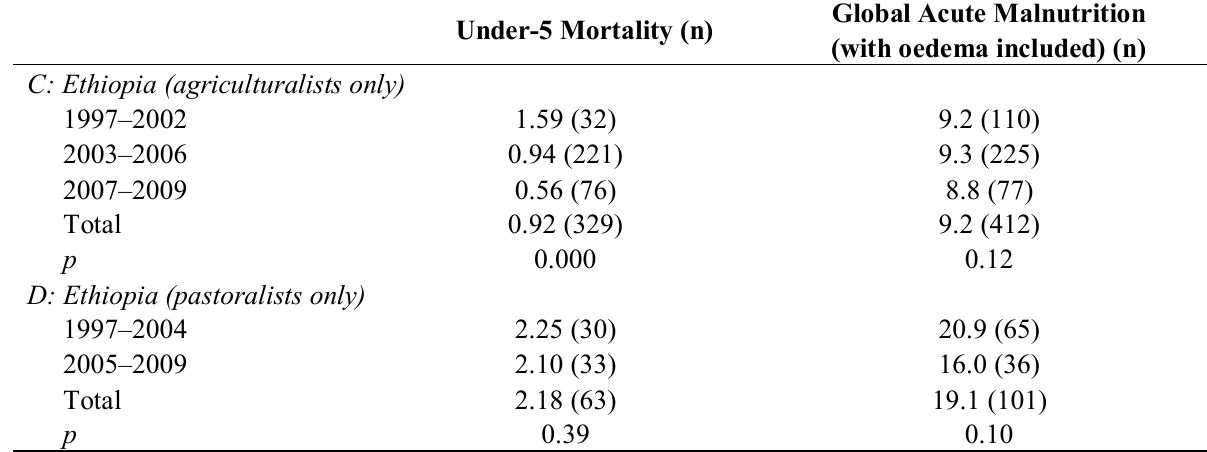
Table 2. Cont. Under-5 Mortality (n)